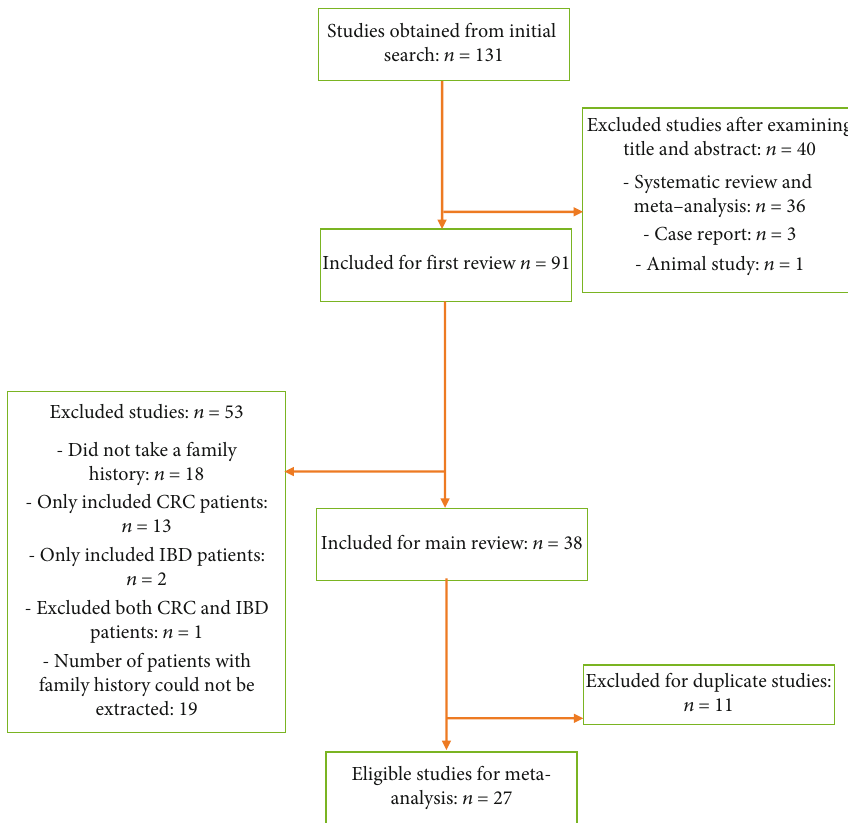
Figure 1: Flow chart for the process of study